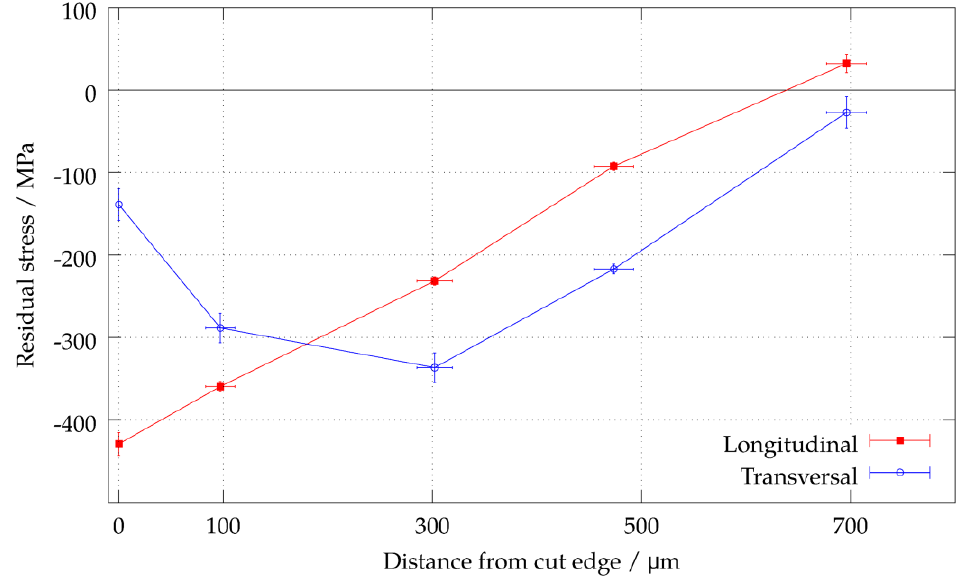
Figure 11. Distribution of residual stresses according to distance to cut edge.